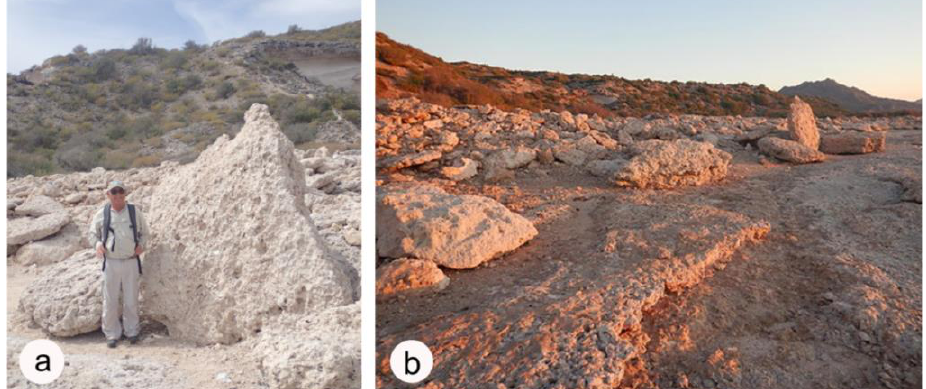
Figure 3. Before and after photos showing some of the largest limestone blocks on the 12 Arroyo Blanco: ( a ) Upturned limestone block photographed from the front at midday in February m terrace at Arroyo Blanco: ( a ) Upturned limestone block photographed from the front 2018 with person for scale; ( b ) Same block photographed in the distance from the side (upper right) at midday in February 2018 with person for scale; ( b ) Same block photographed in the in context with smaller blocks early on a September day in distance from the side (upper right) in context with smaller blocks early on a September day in 2022.